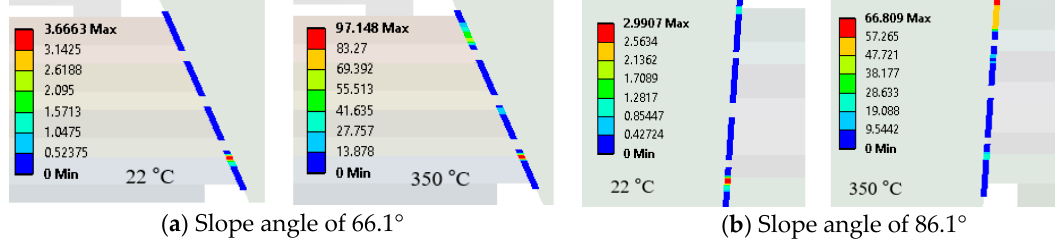
Figure 16. Contact stress distribution at stainless steel of the 7-layer model with graphite thickness of 0.8 mm.